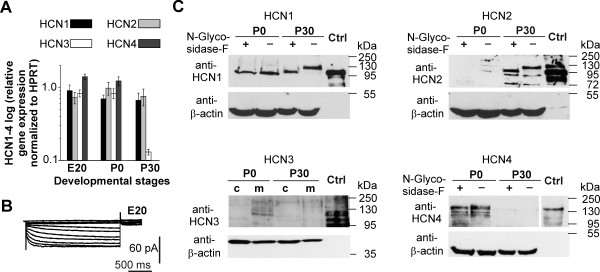
Developmental expression change of HCN subunits. (A) Quantitative real-time PCR of rat neocortical tissue for developmental stages E20, P0 and P30 revealed age-dependent changes in HCN3 and HCN4 mRNA expression levels, whereas the expression of HCN1 and HCN2 remained stable. Data were normalized to respective HPRT expression. Experiments were repeated three times and error bars represent SEM. (B) A family of pharmacologically isolated Ih at E20 recorded from a holding voltage of −40 mV and activation potentials between −40 and −130 mV confirmed a functional expression of Ih already at E20. (C) Western blot analysis from neocortical lysates for HCN1-HCN4 proteins at P0 and P30. For all blots we used anti-beta-actin as loading control and the corresponding subunits (HCN1-HCN4) over-expressed in HEK293 cells as positive controls (ctrl, right lanes). HCN1, HCN2 and HCN4 membrane protein fraction probes were treated with peptide:N-glycosidase F (PNGase F) in order to remove N-linked glyocsylation. HCN1 was detected in both, P0 and P30 protein extracts, but at higher molecular weights at P30. Deglycosylation at P30 shifted the band to lower molecular weights. However, no shift was observed at P0. Note that the bands at P0 still do not match the bands of deglyocsylated P30 protein. HCN2 was not detectable at P0 but at P30. Deglyocosylation of protein extracts shifted the top band to a lower molecular weight in the P30 samples. HCN4 was only detectable at P0 and the upper band was partially reduced by PNGase F treatment. HCN3 was present in membrane extracts of P0 neocortex tissue whereas no protein was detectable in P30 membrane fractions.